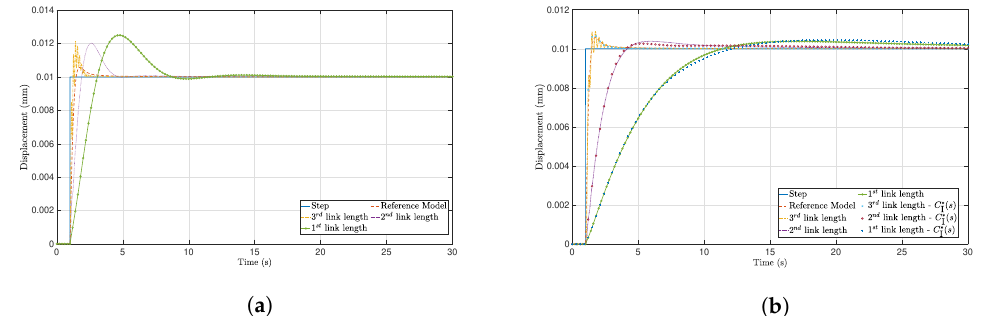
Figure 11. Step response of each robot link when applying: ( a ) PID controller, ( b ) non-integer order integrator and its approximation.